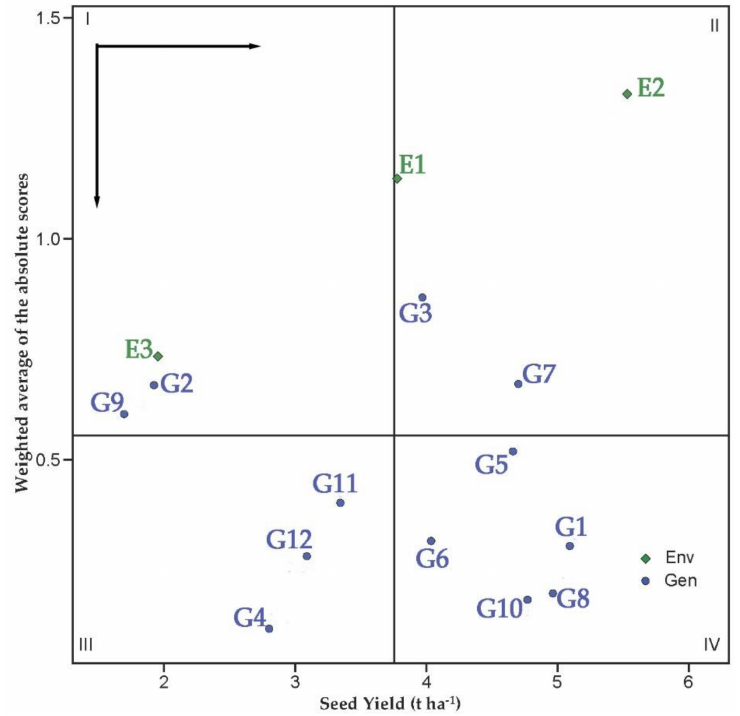
Figure 6. Biplot of the SY vs. the weighted average of absolute scores for the best linear unbiased predictions of the genotype × environment interaction (WAASB) of the 12 chickpea accessions evaluated during three consecutive growing seasons. Horizontal and vertical black arrows indicate the direction of the increase in yielding and stability, respectively. Values from 1 to 12 represent the different accessions (see Table 1 for more details). E1, E2, and E3 indicate: 2017, 2018, and 2019 growing season,